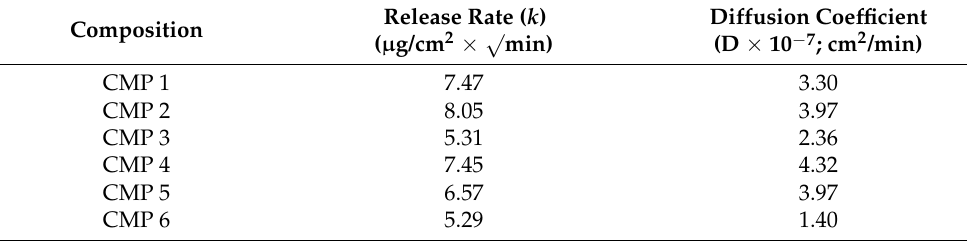
Table 8. Release-rate and diffusion-coefficient values of the